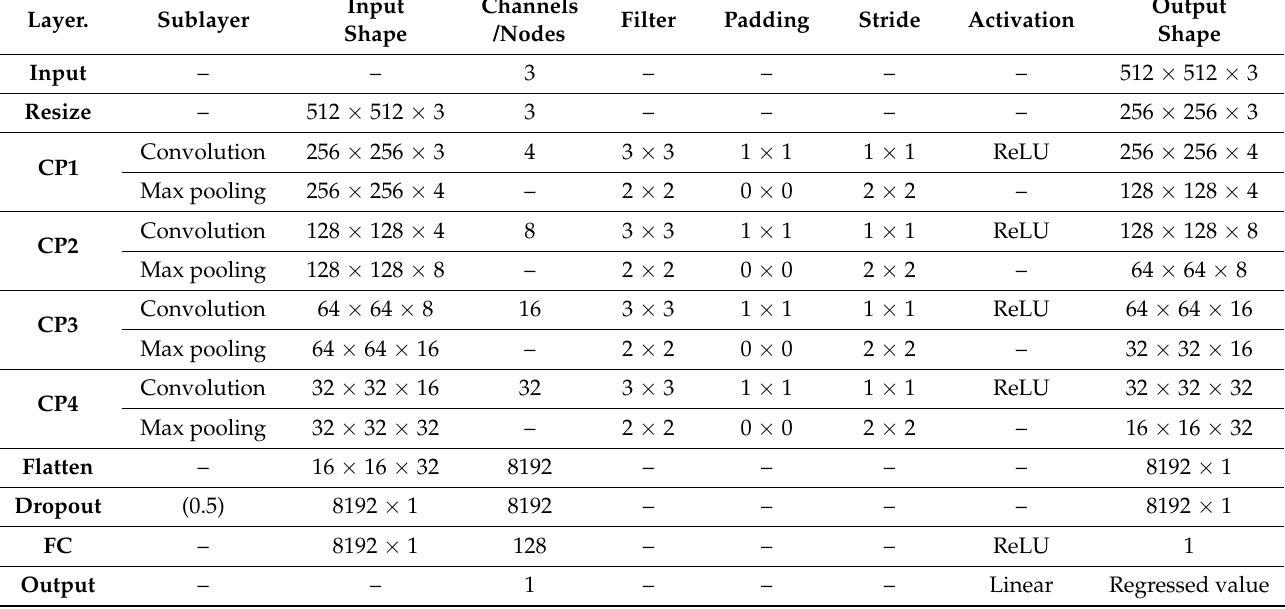
Table 1. Model of CNN for estimation of average grain size used in this